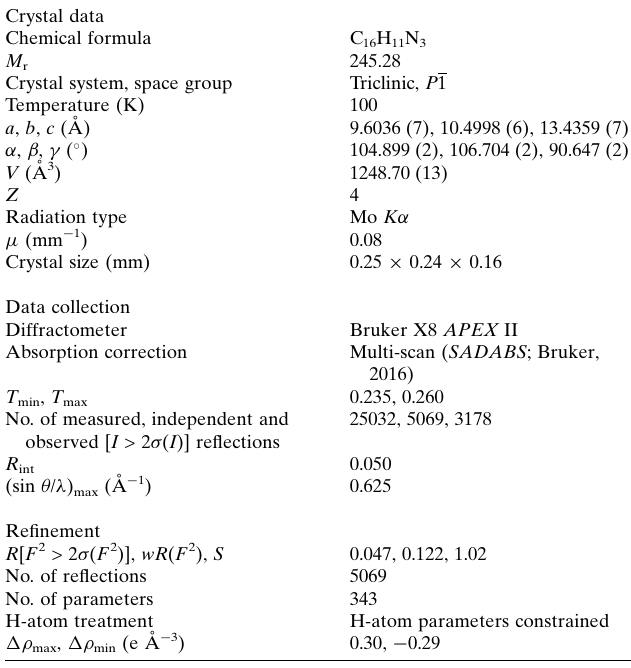
Table 2 Experimental details.